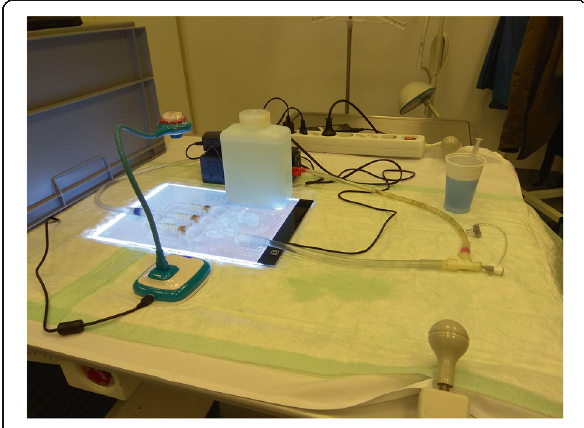
Fig. 3 Model, LED panel and camera are hidden inside the plastic box. The laptop, connected to the camera, displaying the